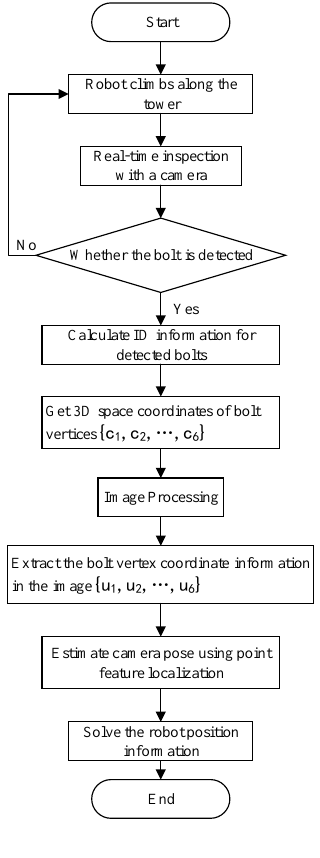
Figure 12. Positioning flow